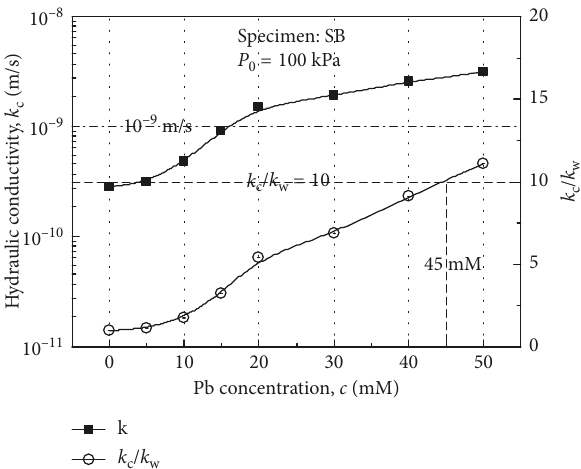
Figure 10: The hydraulic conductivity of ( k exposed to Pb(NO 3 ) 2 solution with 0 to 50mM.